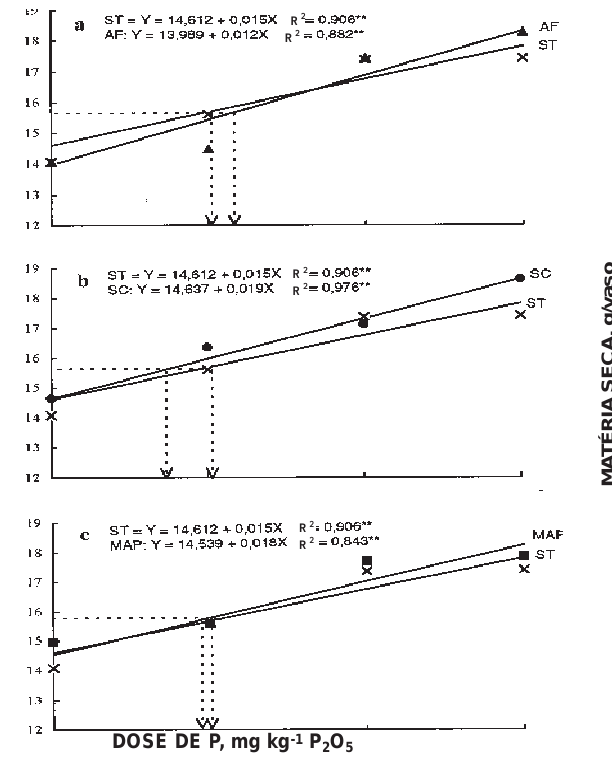
Figura 2. Produção de matéria seca das plantas de milho, em função de doses de fosfato no latosssolo vermelho-amarelo, unidade Três Barras. A inclusão das linhas pontilhadas ilustra o cálculo do equivalente em superfosfato triplo (EqST) para o ácido fosfórico (a), suspensão coloidal 10-30-00 (b) e fosfato monoamônico (c) (AF: ácido fosfórico; SC: suspensão coloidal 10-30-00; ; MAP: fosfato monoamônico; e ST: superfosfato triplo).